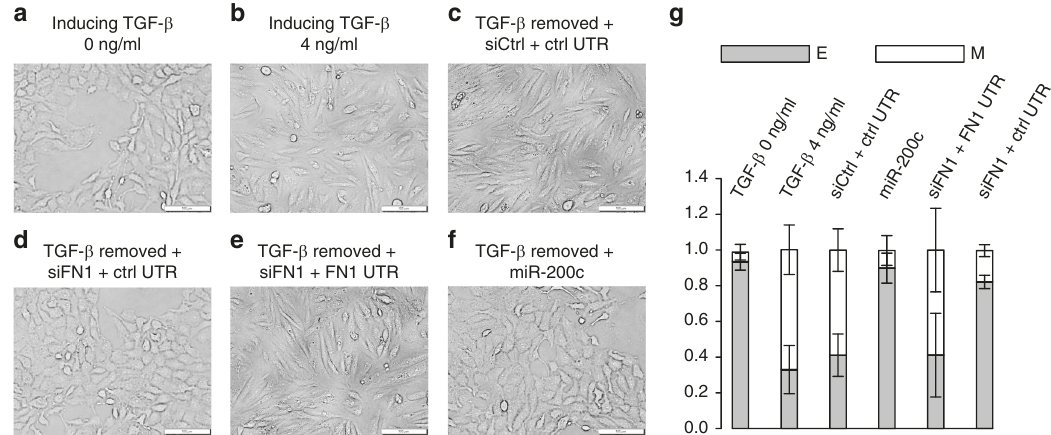
Fig. 7 CeRNA abundance determines EMT reversibility in MCF10A cells. a Morphologies of untreated MCF10A cells. b Morphologies of MCF10A cells treated with 4 ng/ml of TGF- β for 7 days to induce EMT. c Morphologies of cells treated by 4 ng/ml TGF- β for 7 days followed by TGF- β removal and treated with control siRNA and control UTR for 3 days. d Morphologies of MCF10A cells treated by 4 ng/ml TGF- β for 7 days followed by TGF- β removal and treated with siFN1 and control UTR for 3 days. e Morphologies of cells treated by 4 ng/ml TGF- β for 7 days followed by TGF- β removal and treated with siFN1 and FN1 UTR for 3 days. f Morphologies of cells treated by 4 ng/ml TGF- β for 7 days followed by TGF- β removal and treated with miR-200c for 3 days. g Cells in ( a – f ) were subjected to fl ow cytometry analysis by double staining with CDH1 and VIM antibodies and quanti fi ed into E (epithelial cells, gray bars) and M (mesenchymal cells, white bars). The images in ( a – f ) are representative of three independent biological replicates. Scale bars: 100 μ m. n = 3; error bars indicate the means ± s.d.